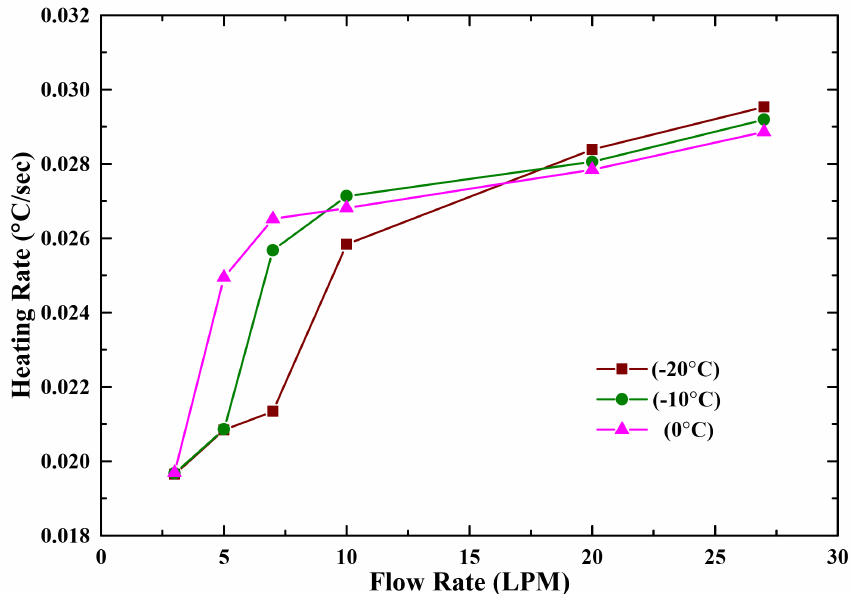
Figure 8. Heating rate as a function of flow rate with heater capacity: 2 kW.